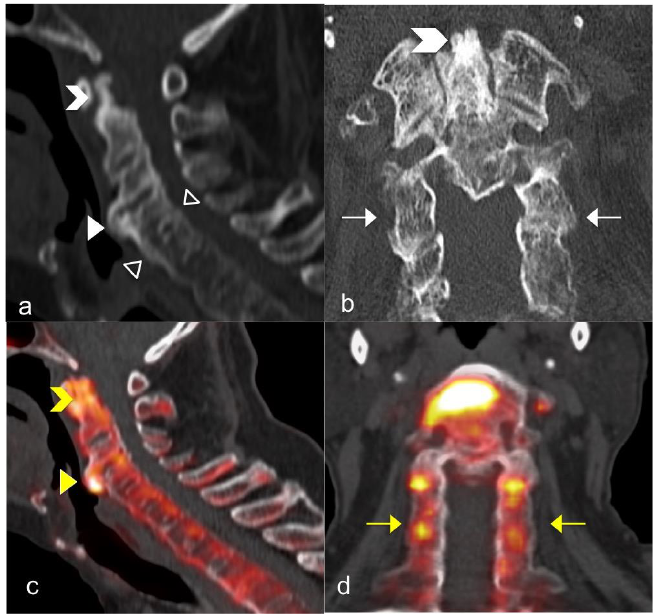
Figure 1. A 66-year-old man with axial PsA. The CT image on the sagittal plane ( a ) shows extensive new bone formation with bridging-syndesmophytes along the anterior and posterior corner (empty white arrowheads) also with bridging-osteophytes between C3-C4 level (white arrowhead); CT images on the coronal plane ( b ) show extensive structural damage with bony erosion and sclerosis of dens (white chevron) also with multilevel ankylosis of facet joints (white arrows). Sodium 18F-Fluoride PET-CT of the cervical spine on the sagittal ( c ) and coronal plane ( d ) shows an increase in tracer uptake at the dens (yellow chevron), at the bridging-osteophytes between C3-C4 level (yellow-arrowhead) and along the facet joints